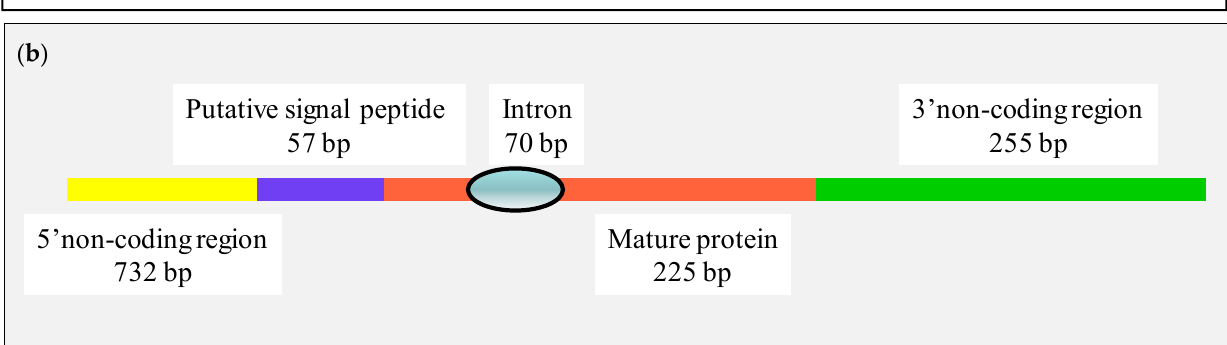
Figure 3. Detailed description of the ICARUS gene ( a ). Sequence of the ICARUS coding region beginning at the transcription starting point. Protein sequence is shown below the exonic regions, with the putative signal peptide underlined. The only intron is highlighted in yellow. The amino acids are shown in green. ( b ). Summary of the ICARUS transcript structure.